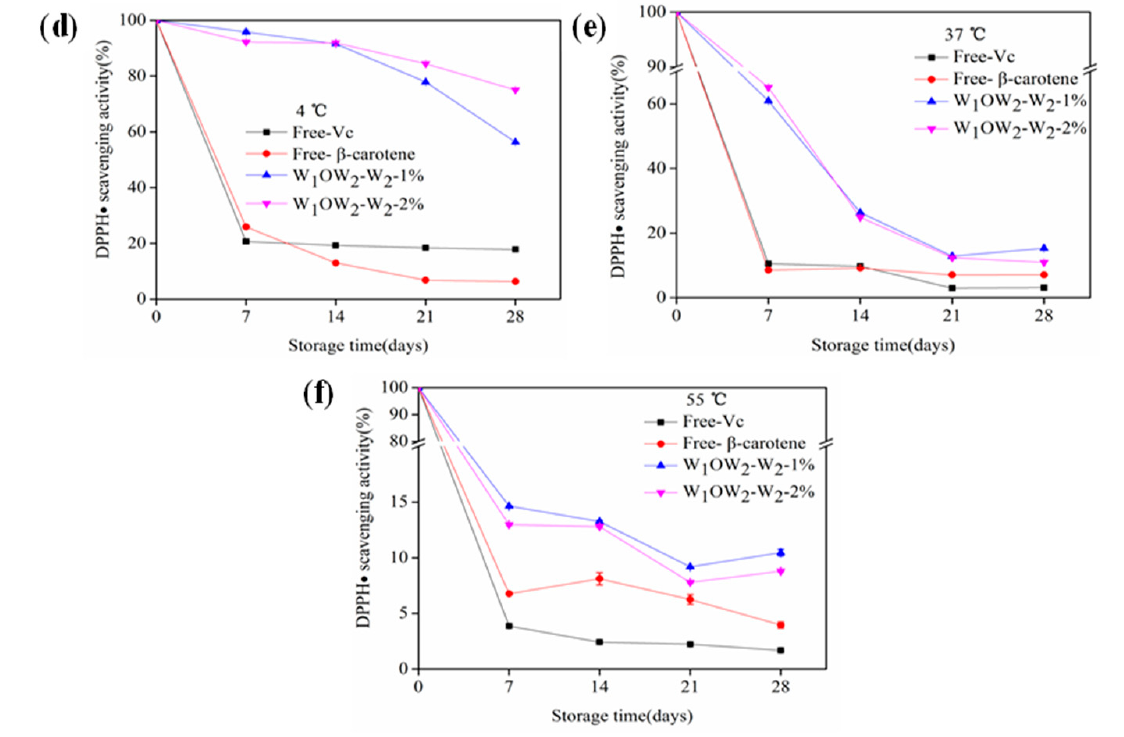
Figure 9. The retention of antioxidant ability of β -carotene and vitamin C in W 1 /O/W 2 emulgels stored at 4, 37, and 55 ◦ C for 28 days. ABTS+ ( a – c ) scavenging activity method. DPPH ( d – f ) scaveng- ing activity method.